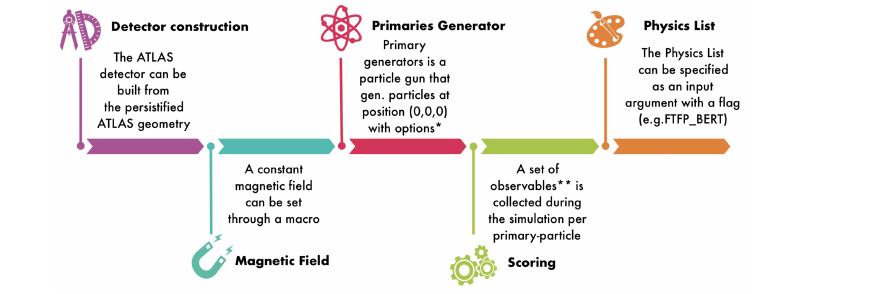
Figure 4: Sketch describing the main components of FullSimLight application at the present